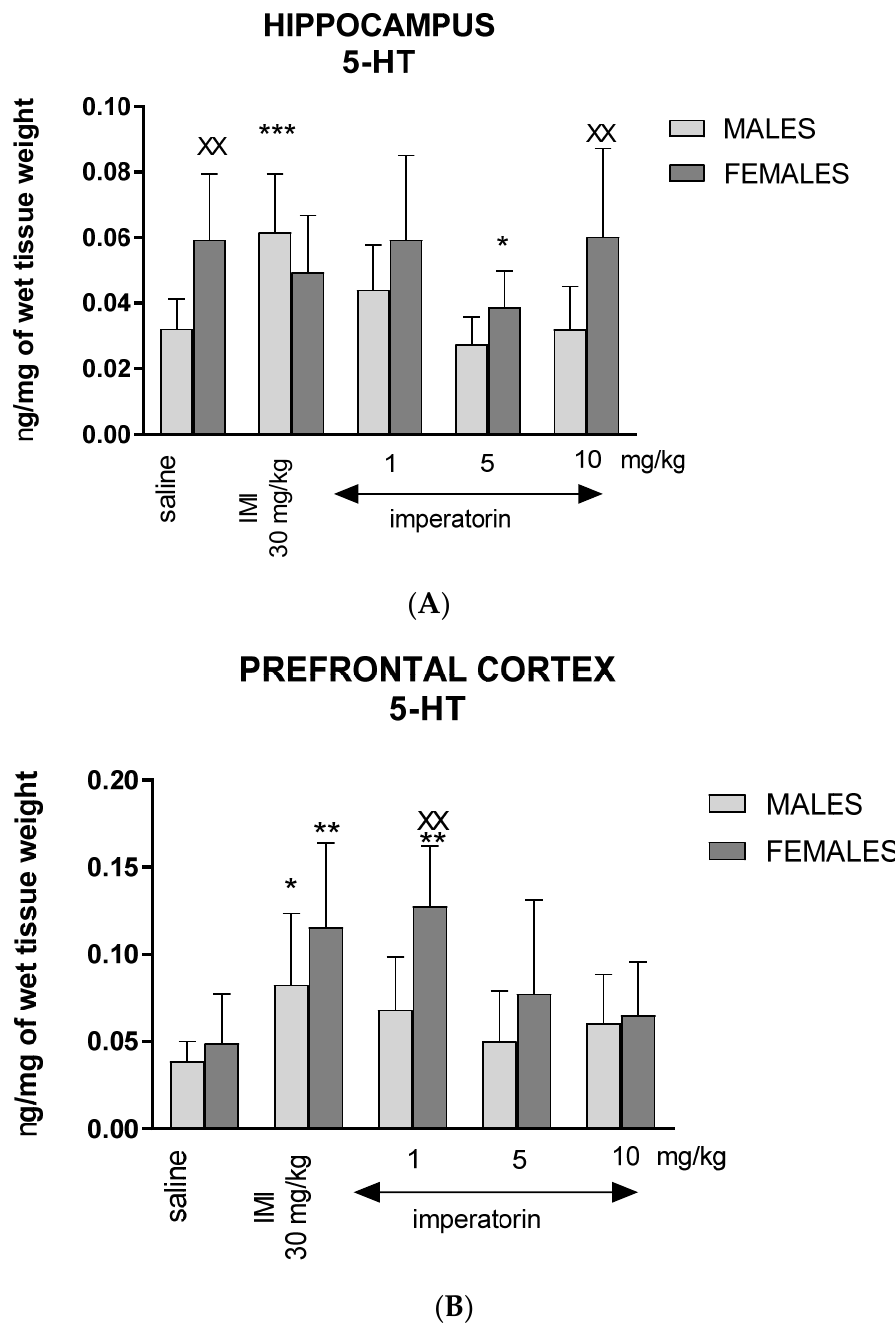
Figure 3. The Serotonin (5-HT) level in the hippocampus ( A ) and prefrontal cortex ( B ) after imipramine (IMI) and imperatorin injections ( i.p. ). Imipramine (IMI, 30 mg/kg) and imperatorin (1, 5 and 10 mg/kg) were administered 30 min before FST. The hippocampus ( A ) and prefrontal cortex ( B ) were dissected immediately after the test; n = 8–10; mean ± SD; * p < 0.05, ** p < 0.01, *** p < 0.001 vs. saline-treated control group, XX p < 0.01 vs. male group; Bonferroni’s test. Two-way ANOVA analysis revealed a statistically significant sex difference (F (1, 86) = 11.85, p = 0.0009), and drug treatment effect (F (4, 86) = 7.625, p < 0.0001), but no significant sex * drug interaction (F (4, 86) = 1.531), p = 0.2016) on 5-HT levels in the prefrontal cortex (Figure 3B). Post hoc pairwise comparisons with Bonferroni’s correction showed in- creased level of 5-HT in females after imperatorin injection (1 mg/kg: ** p < 0.01 vs. saline). Imperatorin (1 mg/kg: XX p < 0.01) caused an increase in 5-HT levels in females vs., males. Additionally, imipramine (for 30 mg/kg: ** p < 0.01) in females and males (30 mg/kg; * p < 0.05) caused increase in 5-HT level vs. female and male control groups, respectively (Fig- ure 3B). 2.5. Imperatorin Alters 5-Hydroxyindoleacetic Acid Tissue Levels in the Hippocampus and Prefrontal Cortex Two-way ANOVA analysis revealed no drug treatment effect (F (4, 86) = 1.896, p = 0.1470, and no significant sex difference (F (1, 86) = 0.04010, p = 0.8419), but a significant sex * drug interaction (F (4, 86) = 3.020, p = 0.0234) in the hippocampus with respect to 5-HIAA levels was observed (Figure 4A).